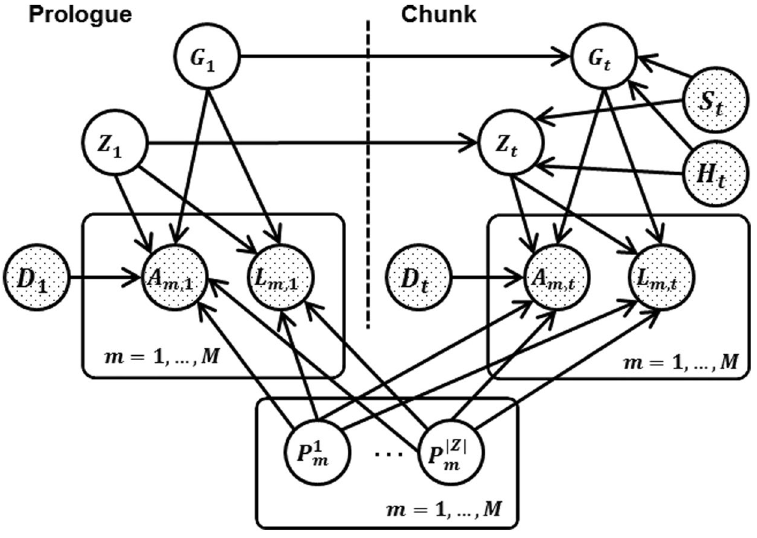
Figure 4. The THEMIS